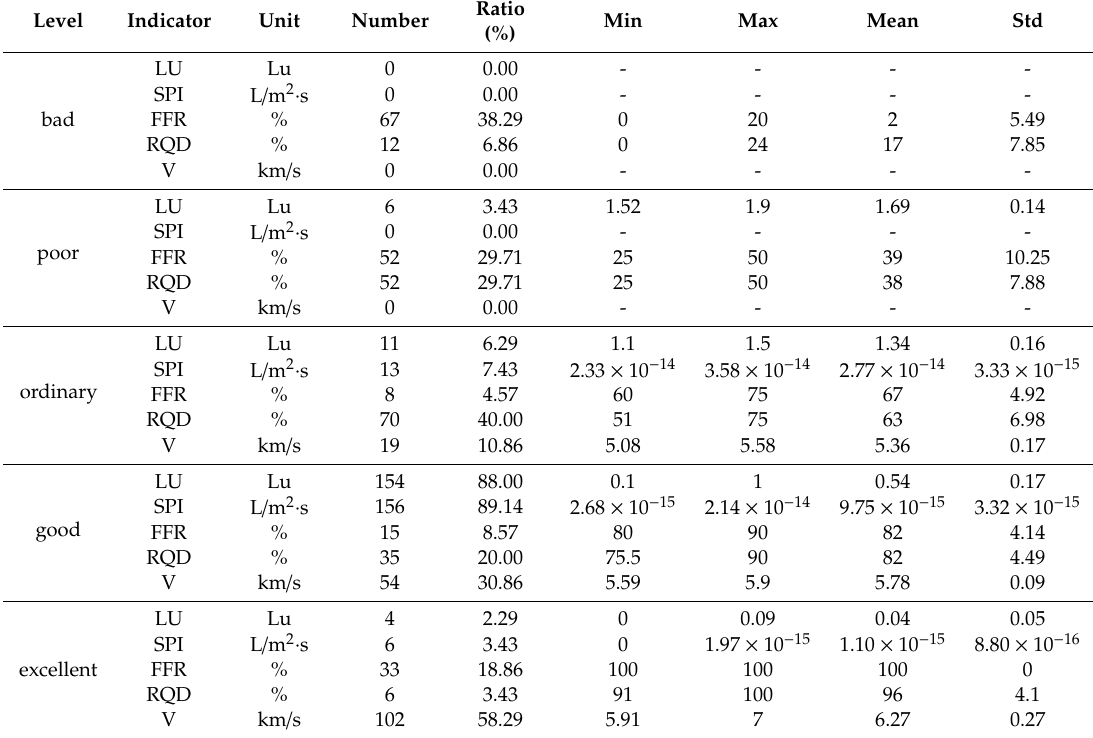
Figure 9. The results of borehole television imaging of the verification hole DJ1-1: ( a ) The image from depths of 4.0–6.0 m; ( b ) the image from depths of 15.0–18.0 m; ( c ) the image from depths of 42.0–44.0 m; and ( d ) the image from depths of 55.0–58.0 m. Table 4. Summary statistics of each indicator variable.